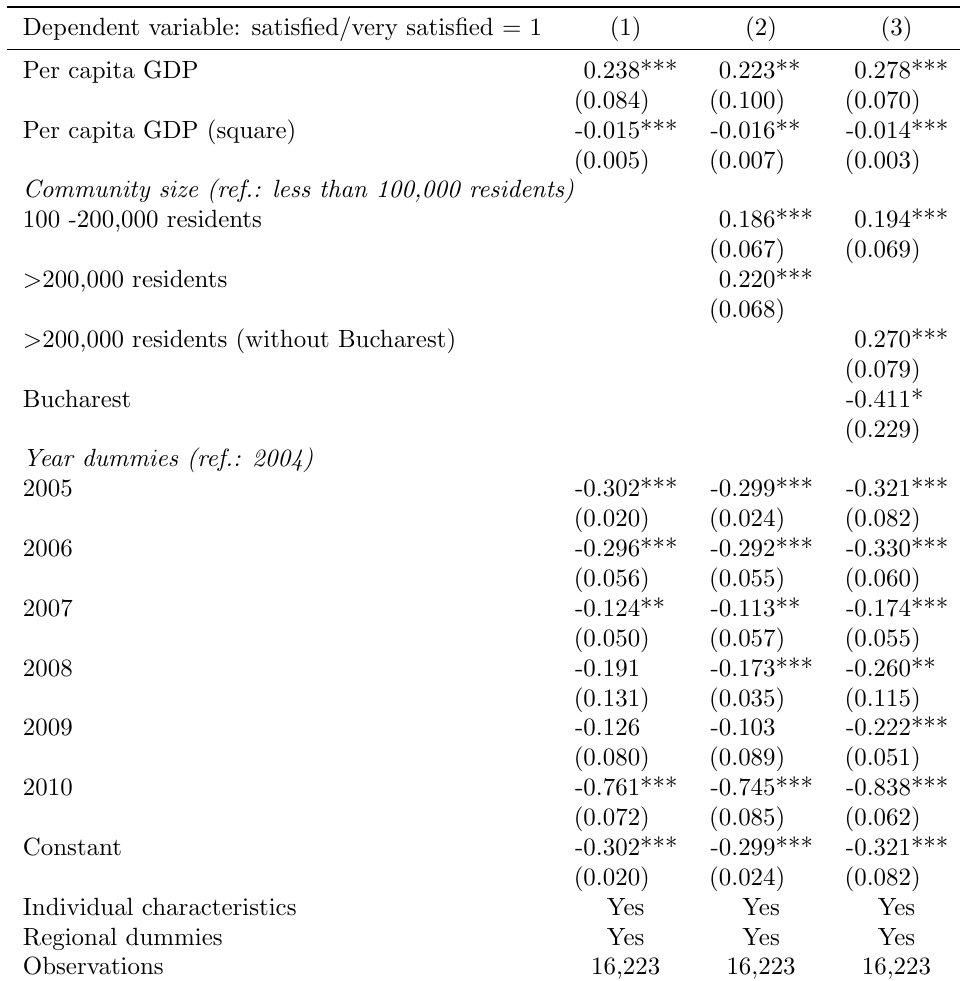
Table 5: Life satisfaction and city size: